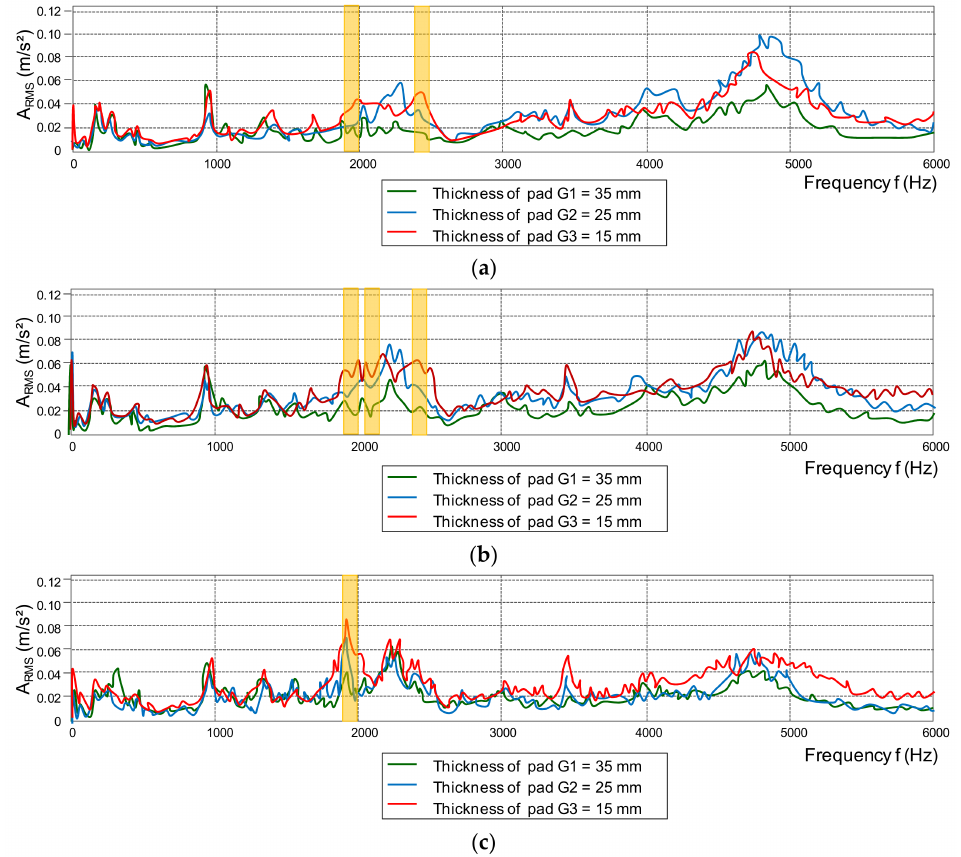
Figure 14. Dependence of the amplitude of vibration accelerations on the frequency for different friction lining thicknesses when braking from the speed: ( a ) v = 120 km/h, ( b ) v = 160 km/h, ( c ) v = 200